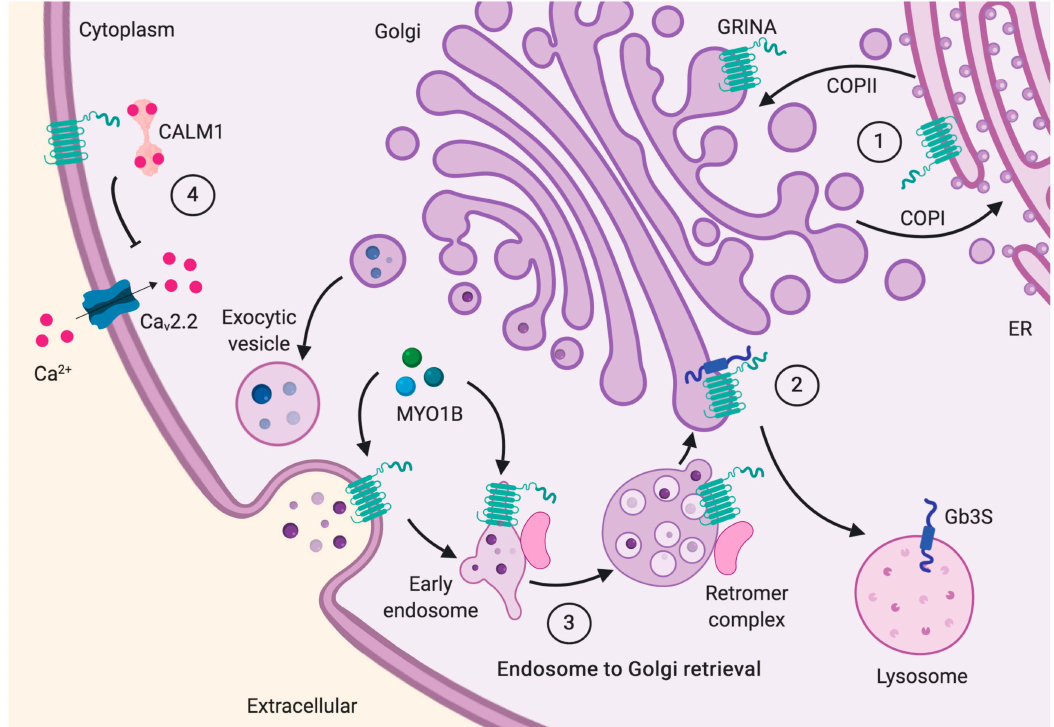
Figure 2. The role of GRINA in vesicle tra ffi c and sorting. (1) GRINA may translocate from the endoplasmic reticulum (ER) to the Golgi using coat protein complex II (COPII) with the assistance of ALG2 in response to a Ca 2 + increase or have the exposed di-Arg motif recognized by COPI for ER retrieval. (2) GRINA may interact with Gb3 synthase (Gb3S), redirecting it to the lysosome. (3) GRINA is required for Endosome-to-Golgi retrieval where it may associate with other proteins like MYO1B. (4) GRINA has been observed also in the plasma membrane where interacts with Ca V 2.2 channels (CALM1) or G-protein β γ subunits, in the regulation of the cellular Ca 2 + influx and the